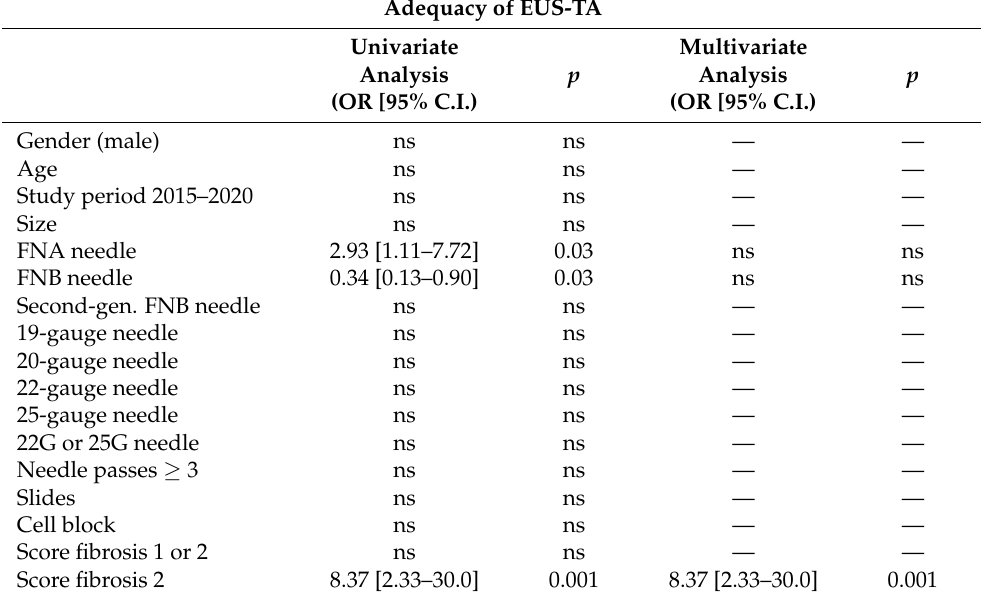
Table 8. Variables related to false negative EUS-guided tissue acquisition results. Adequacy of